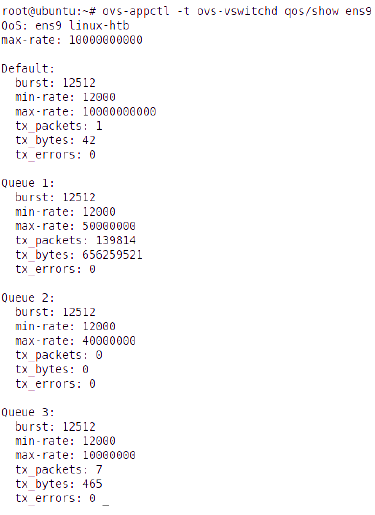
Figure 7. Base station OVS queue parameters in Scenario 2.